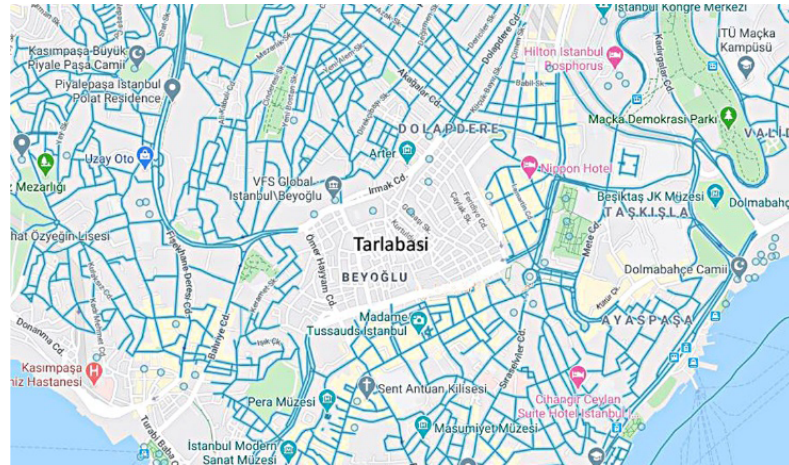
Figure 2. Google Maps’ screenshot. The Tarlabaşı neighborhood is missing with no available street